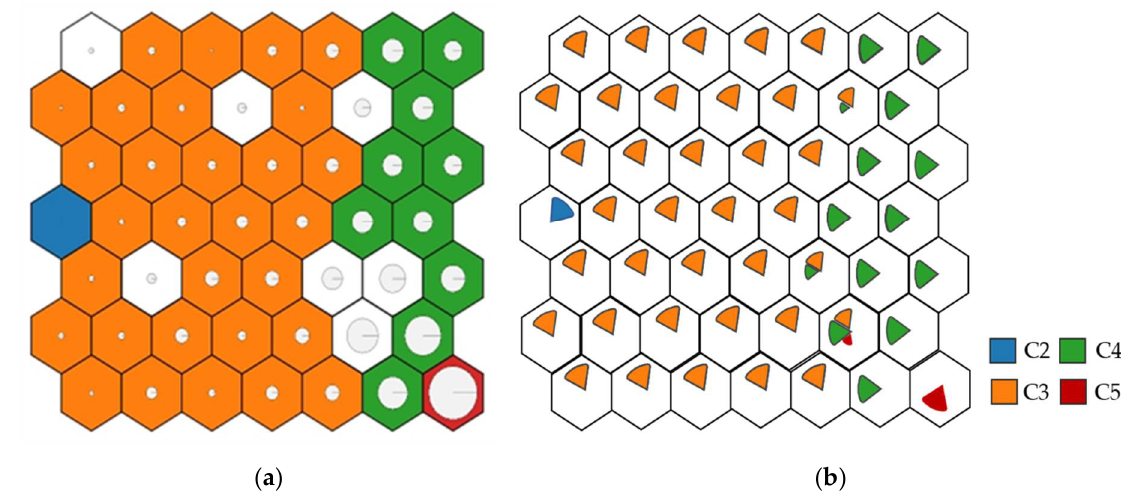
Figure 10. Corrosion zones according to the environment. ( a ) Corrosion representation (larger circle, more corrosion). ( b ) Corrosivity category representation, according to ISO 9223:2012 standard.